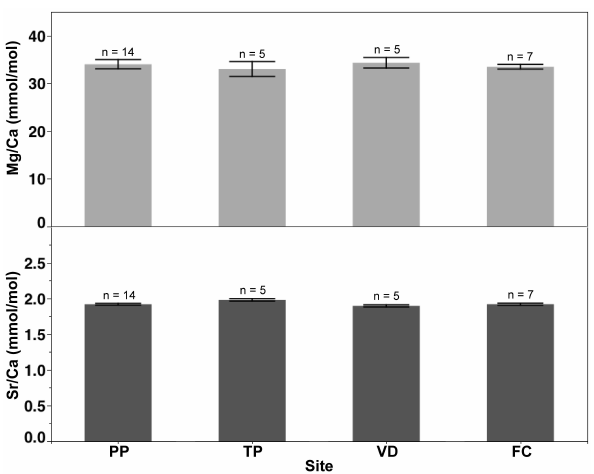
Fig. 4. Mean Mg/Ca (upper) and Sr/Ca (lower) ratios for spines of adult S. purpuratus populations spanning the West Coast US shown in Fig. 1. Error bars represent ± 1SE from mean.